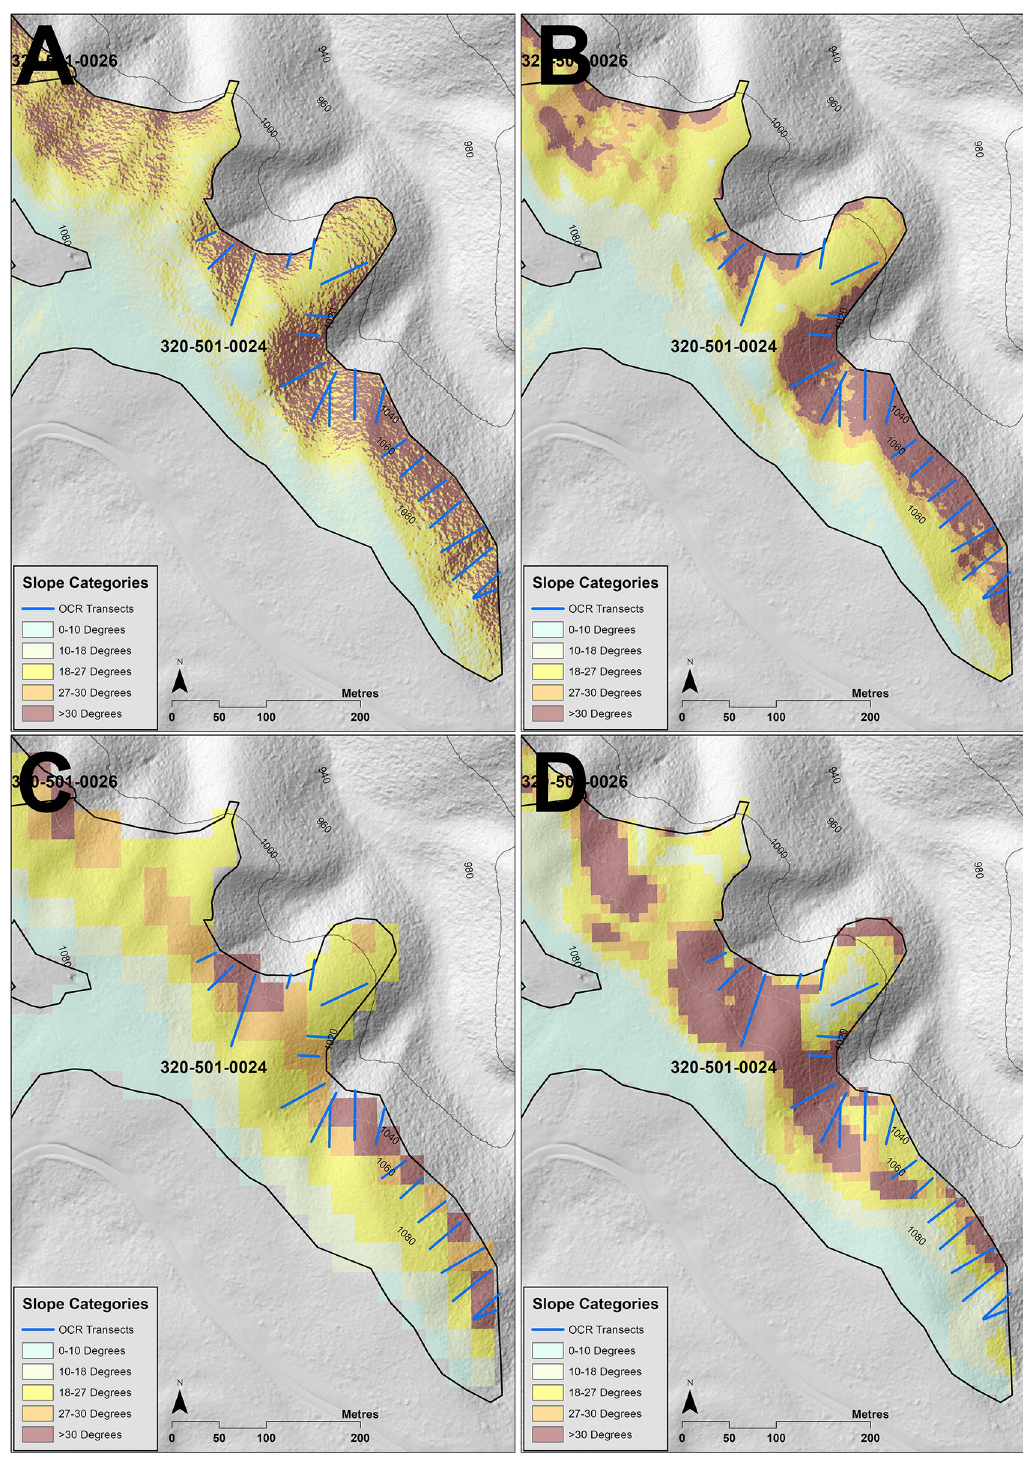
Fig 8. Comparison slope calculations with transects measured on Cutblock 320-501-0024 by the Timber Harvest Compliance Unit of the OCR. LiDAR derived slope at 1m resolution (Fig 8A); LiDAR derived slope with an average slope neighbourhood radius of 5m (Fig 8B); STRM derived slope at 1 arc second resolution (Fig 8C); DTM derived slope at 10m resolution (Fig 8D).